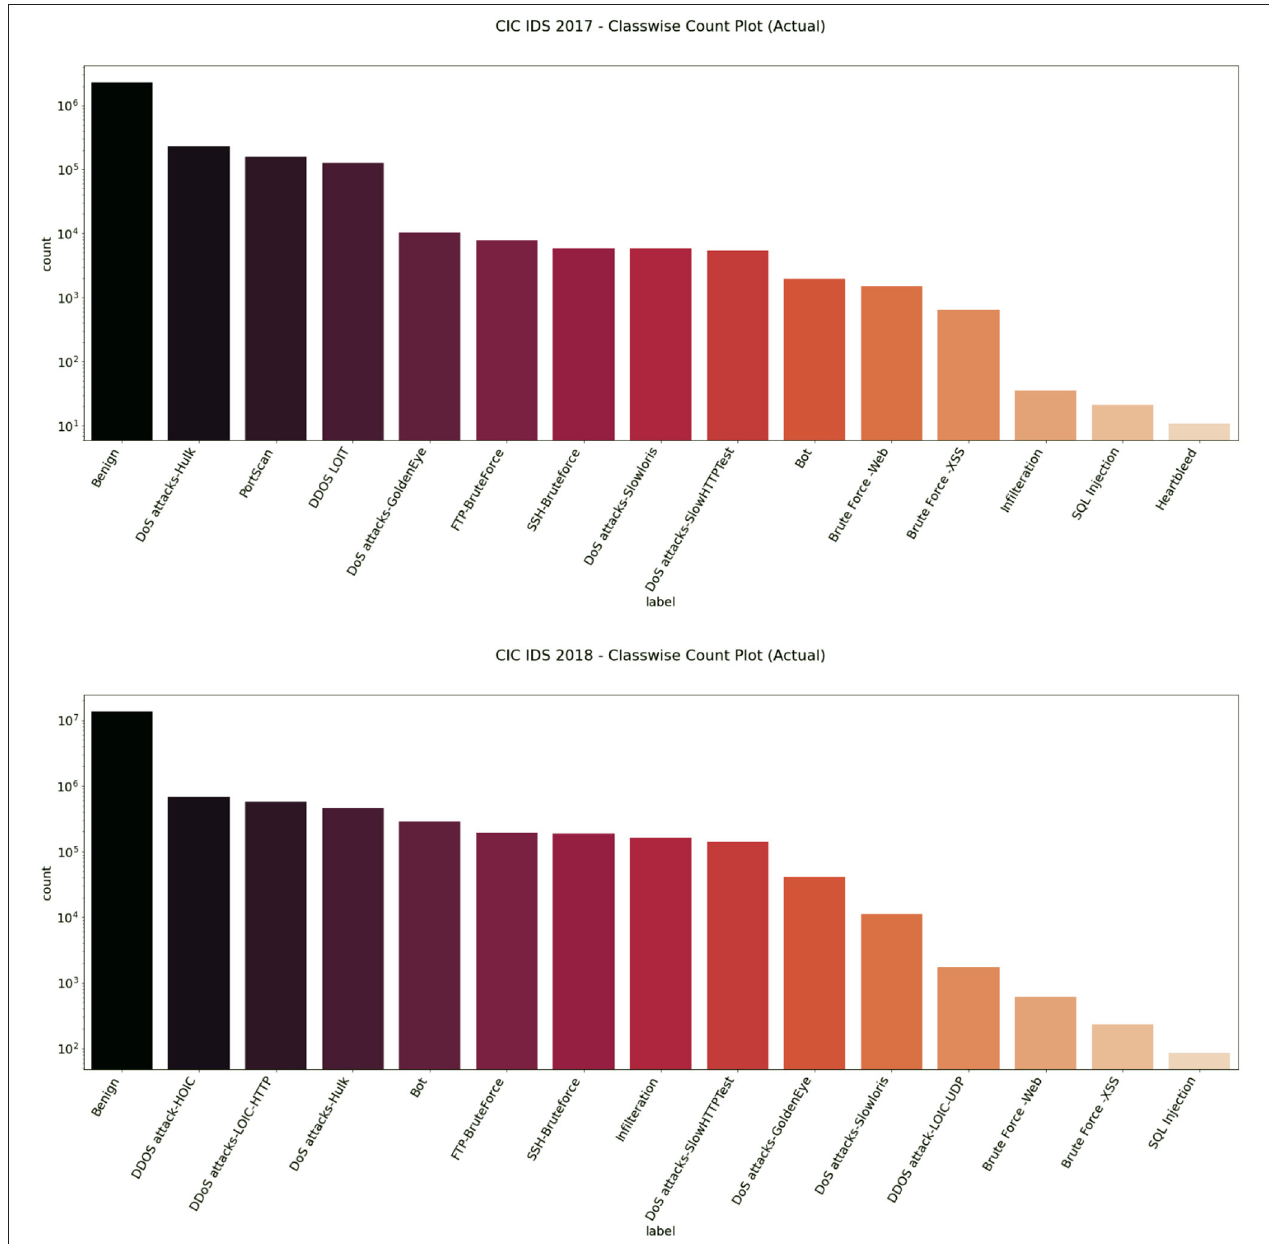
FIGURE 4 | Classwise count plot of CIC IDS 2017 (top) and 2018 (bottom) datasets.